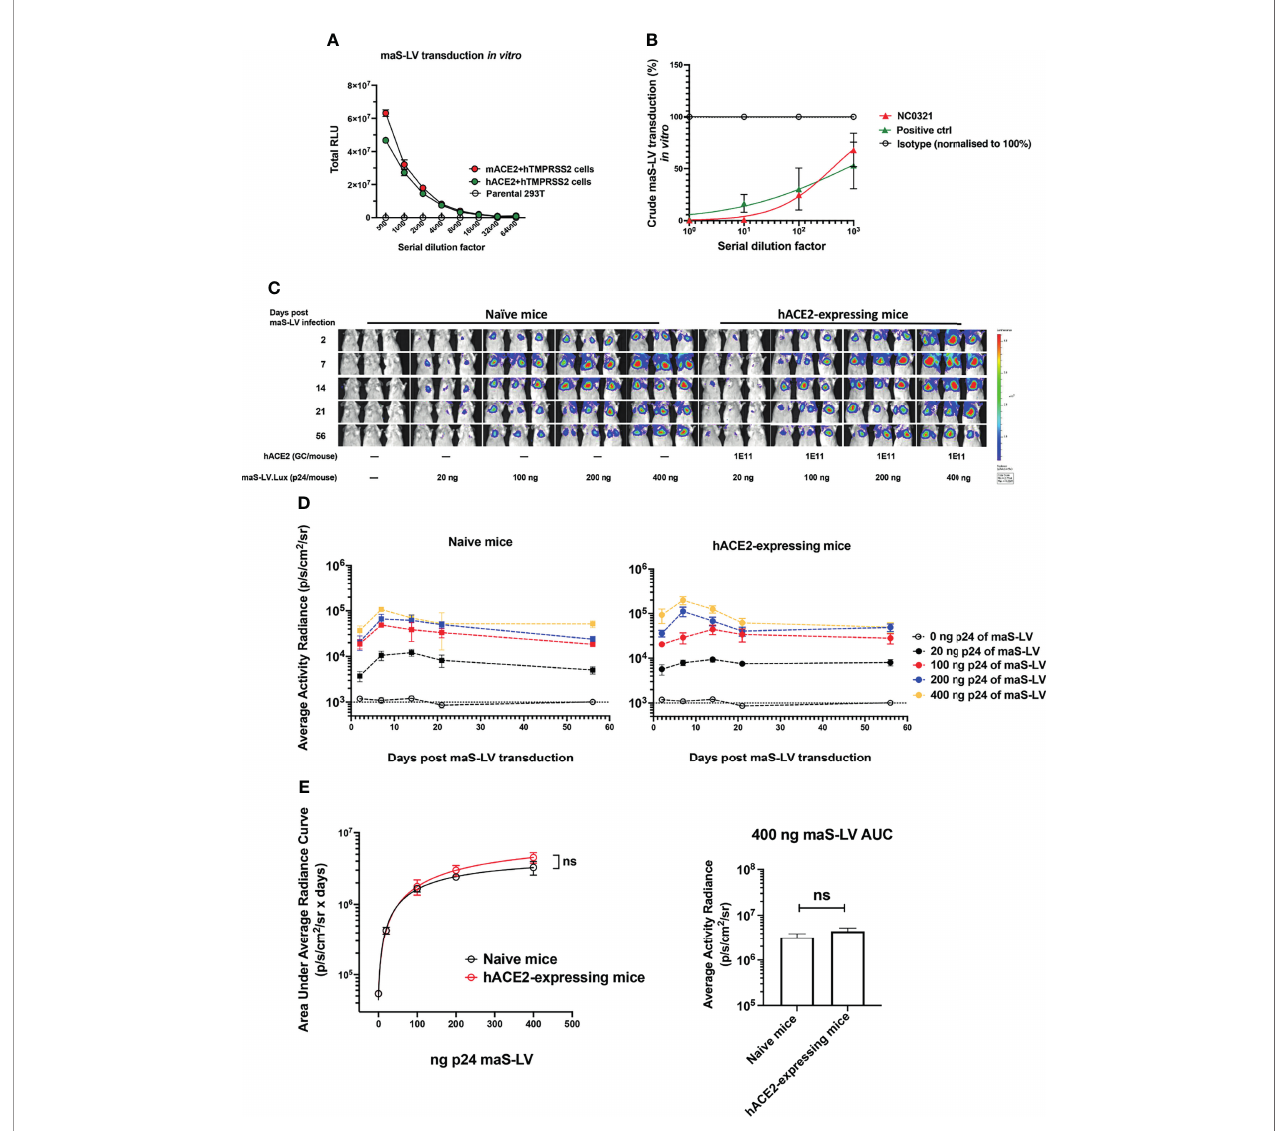
FIGURE 2 | Generation of mouse-adapted SARS-CoV-2 surrogate permits lung transduction in wild-type mice. (A) Mouse-adapted SARS-CoV-2 surrogate (maS-LV) transduction in the parental HEK293T/17, mouse ACE2+TMPRSS2 or human ACE2+TMPRSS2 co-expressing HEK293T/17 cell line was determined (symbols represent mean±SEM, n=3). TMPRSS2, transmembrane protease serine 2 precursor, is important for SARS-CoV-2 spike priming as a serine protease (23). (B) Neutralization activity of NC0321 against an maS-LV expressing EGFP was con fi rmed by fl ow cytometry at the serial dilutions as indicated (n=3). An anti-spike antibody (40592-R001, Sino Biological) acted as positive control. (C) Bioluminescence imaging of mice (5-8 week old, female, n=3/group) at day 2, 7, 14, 21 and 56 dpi with the indicated p24 doses of a maS-LV expressing luciferase. Mice were naïve or received 1E11 Genome copies (GC) rAAV9.hACE2 14 days prior to maS-LV infection. (D) Time-course of bioluminescence imaging data for the indicated treatment groups after maS-LV infection at the indicated p24 dose ±hACE2 as indicated. The dotted line indicates the mean naïve background signal. (E) Area Under Curve (AUC) of bioluminescence (photons/sec/cm 2 /sr) values for each animal in (C) was computed, symbols represent mean±SEM for each treatment group (ANOVA, Dunnett ’ s multiple comparison of AUC between naïve and hACE2-expressing BALB/c mice). The right panel indicates the AUC in naïve and hACE2-expressing mice following treatment with 400ng p24 maS-LV (ns represents p >